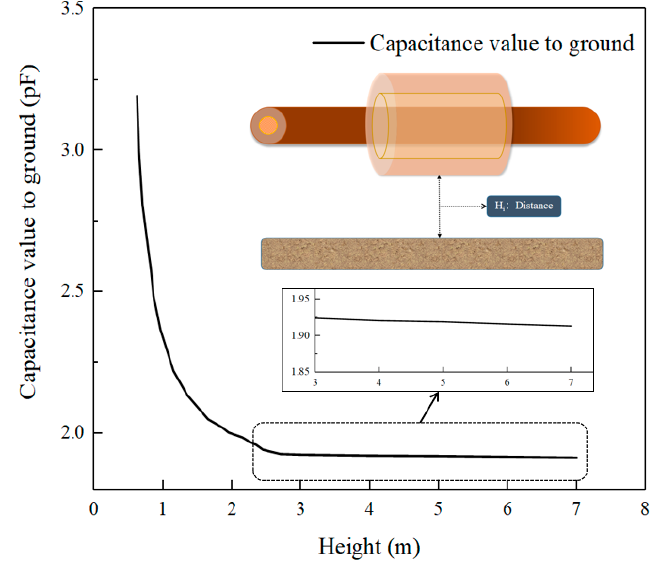
Figure 5. Coupling capacitance simulation results.